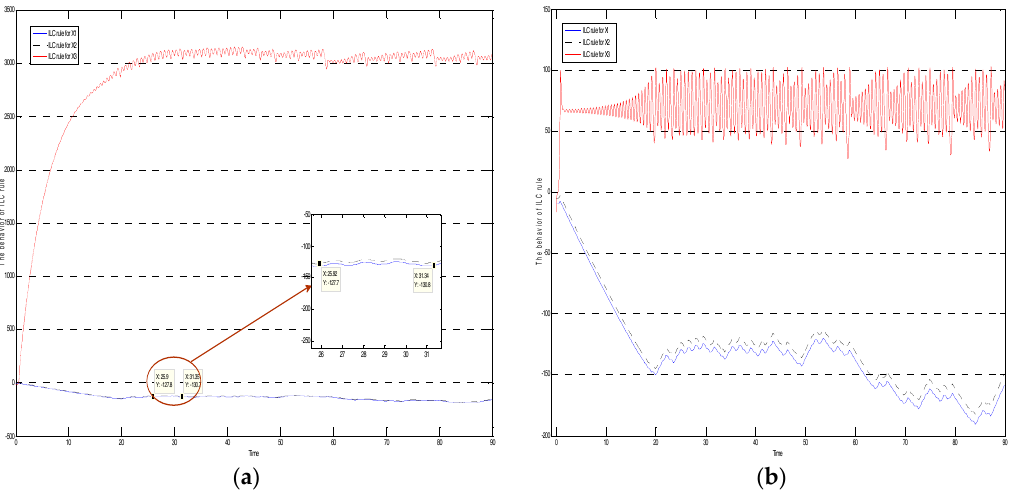
Figure 5. The different behaviors of IL Care chosen as the worst learning law and listed as ( a ) B 1 is identity matrix; and ( b ) B 1 = Dig [0.1, 0.1, and 0.92].